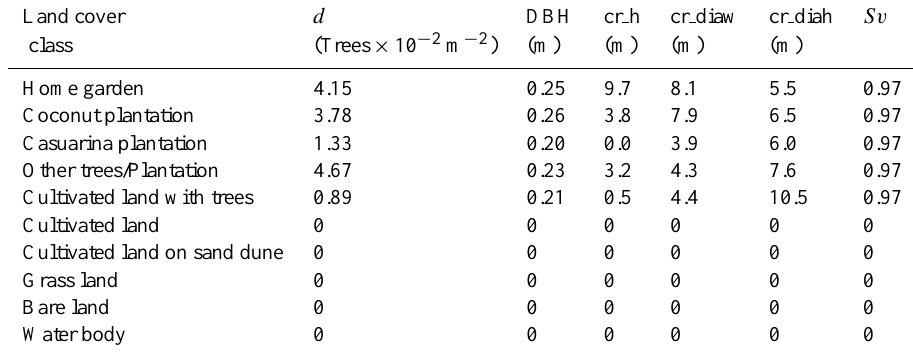
Table 1. The land cover/Land use parameters for the numerical simulation.